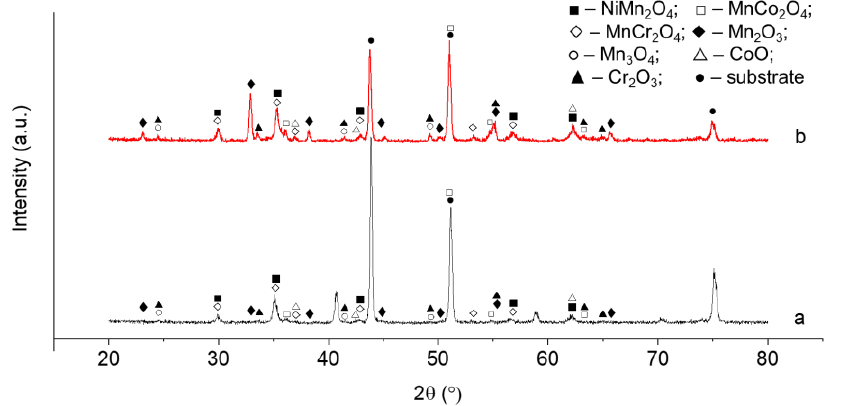
Figure 3. XRD pattern of Cr-Fe steel sample with deposited protective coating after vacuum ( a ) and oxidizing ( b ) annealing. The following PDF2 cards were used: NiMn 2 O 4 — 00-084-0542; MnCo 2 O 4 — 00-084-0482; MnCr 2 O 4 — 00-075-1614; Mn 2 O 3 — 00-073-1826; Mn 3 O 4 — 00-075-1560; CoO — 00-075-0418; Cr 2 O 3 — 00-082-1484.